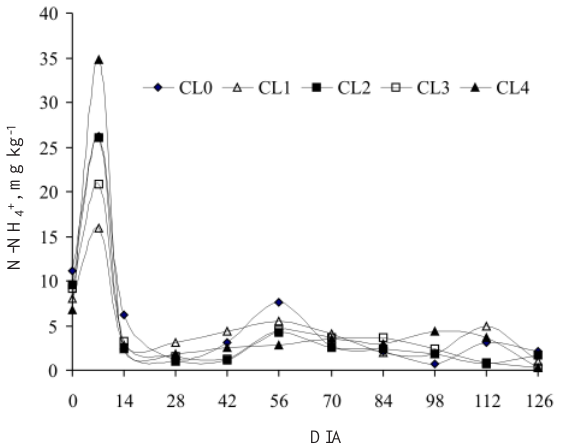
Figura 4. Teores de N-NH 4+ no solo, considerando o tempo de incubação, no tratamento não ) e nos adubados com 30 (CL adubado (CL 0 (CL ); 90 (CL ) e 120 t ha -1 (CL 2 3 de lixo urbano.